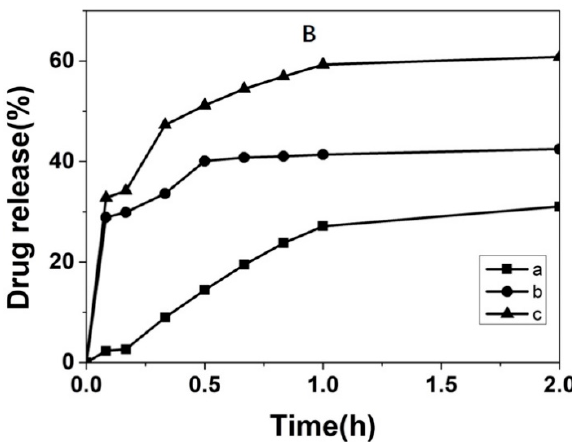
Figure 8. In vitro release profiles of ( A ): ( a ) IBU, ( b ) IBU loaded l -CMS, ( c ) IBU loaded d -CMS in simulated intestinal fluid (SIF) (the inset figure is the enlargement of the rectangle area labeled in Figure ( A ); ( B ): ( a ) IBU, ( b ) IBU loaded l -CMS, ( c ) IBU loaded d -CMS in simulated gastric fluid (SGF). Credit: republished with permission of Elsevier, from Reference [104], Copyright (2019),